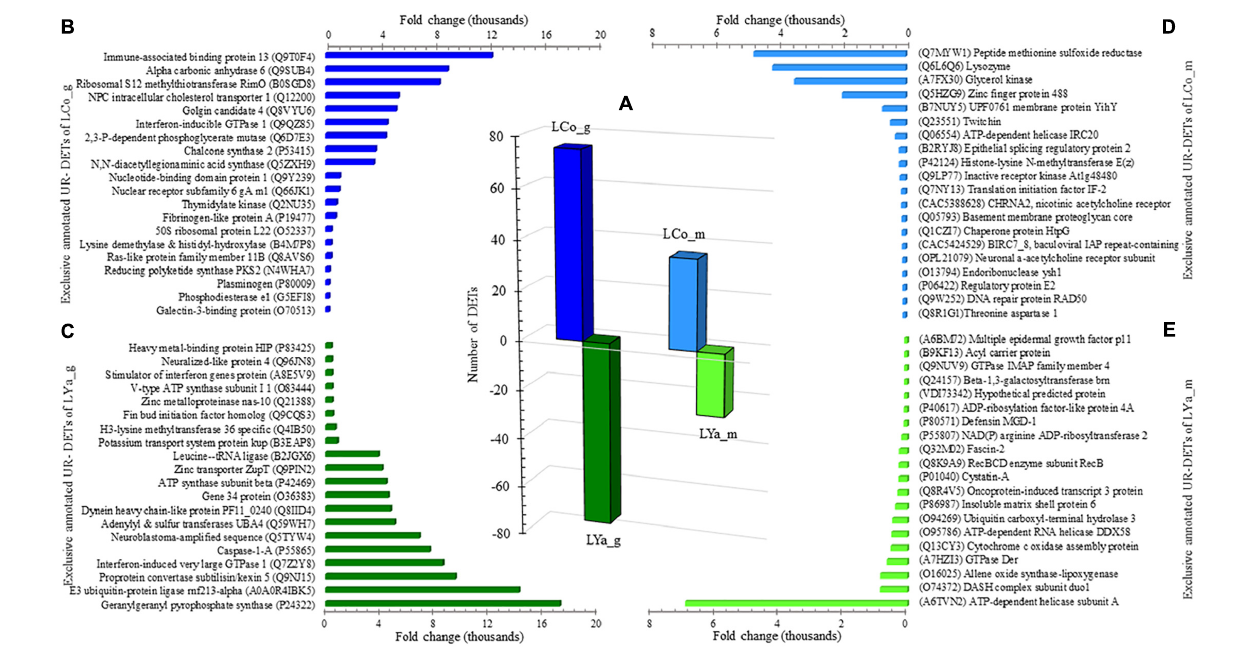
FIGURE 4 | Inter-location by tissue comparison. The number (bars) of differentially expressed transcripts (DETs) by tissue are in the central plot (A) ; the number of up-regulated (UR-) DETs from gills and mantle tissues for Yaldad are in negative values. Also are showed the top twenty exclusive annotated UR-DETs from gill samples from Cochamó (B) and Yaldad (C) . Top twenty exclusive annotated UR-DETs from the mantle are in (D) for Cochamó and (E) samples for Yaldad. LCo, local individuals from Cochamó and LYa, locals from Yaldad. _m, mantle samples and _g, gill